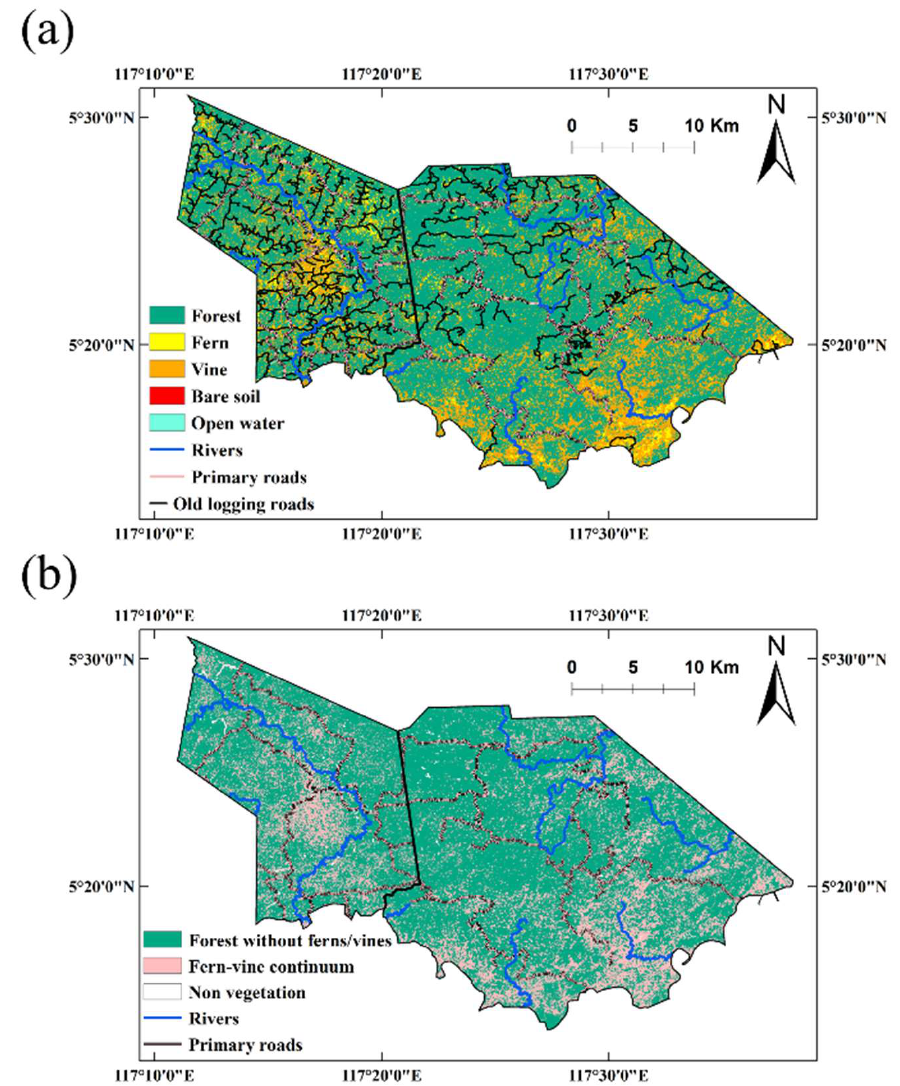
Figure 6. ( a ) The vegetation map of Deramakot and Tangkulap Forest Reserve as of 2019. This map was obtained by spatial extrapolation of the best model (VI_TEX_SAR data set with the voting method). Green represents forest, yellow represents fern, orange represents vine, red represents bare soil, and blue represents open water class, the pink line represents main roads, the black line represents old logging roads, and the blue line represents rivers; ( b ) the modified vegetation map of the forest reserves. This map was obtained by reclassifying the original five land-cover types into three. Green represents forest without ferns or vines, pink represents the fern–vine continuum, and white represents the non-vegetation class, the blue line represents rivers, and the pink line represents main roads. The overall classification accuracy, producer’s accuracy, and user’s accuracy for each land-cover type are shown in Figure 7, and the area of each land-cover type is provided in Table 4.